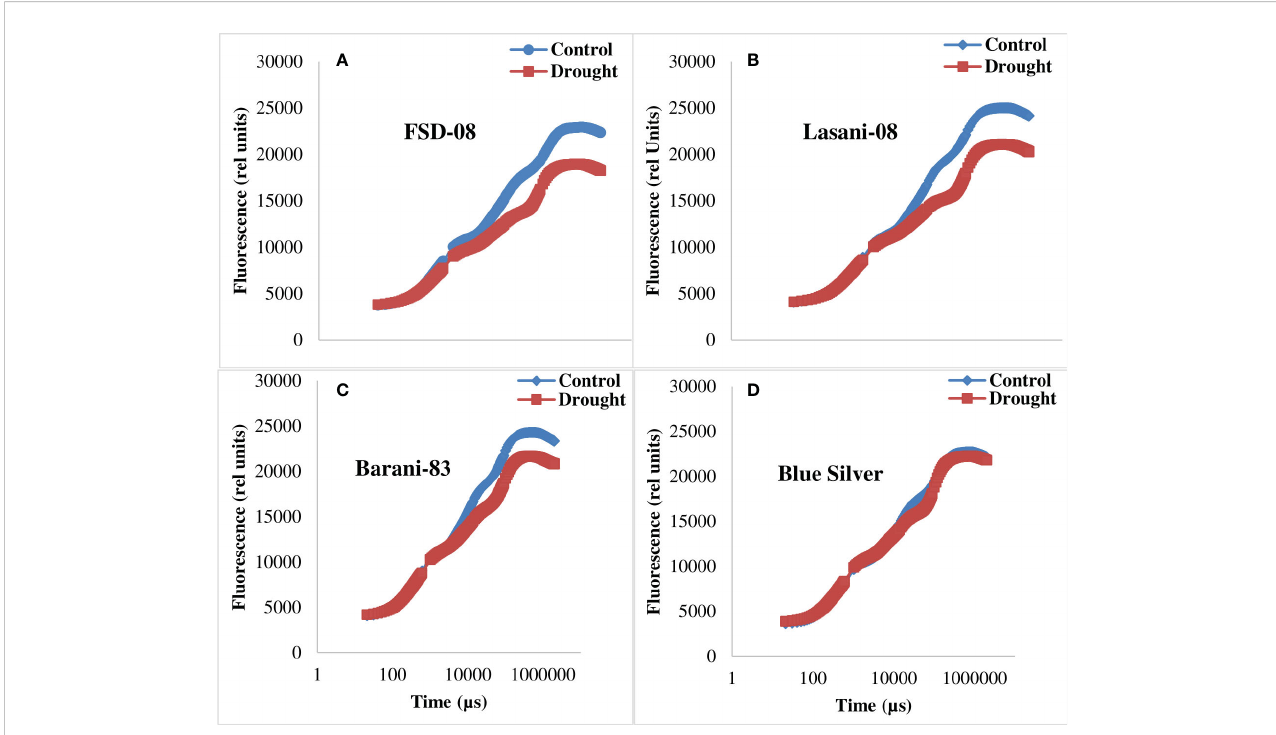
FIGURE 8 Raw OJIP chlorophyll a fl uorescence curves (Ft) of the four selected wheat cultivars when plants were subjected to control or drought stress at adult stage. (A) FSD-08, (B) Lasani-08, (C) Barani-83, and (D) Blue